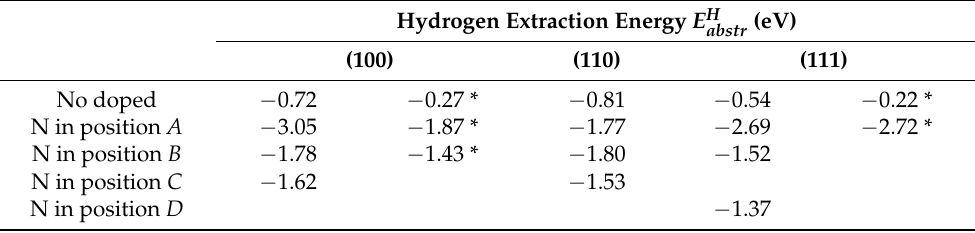
Table 3. Methyl group hydrogen extraction energy E H surfaces with or without nitrogen doping at positions A , B , C , and D